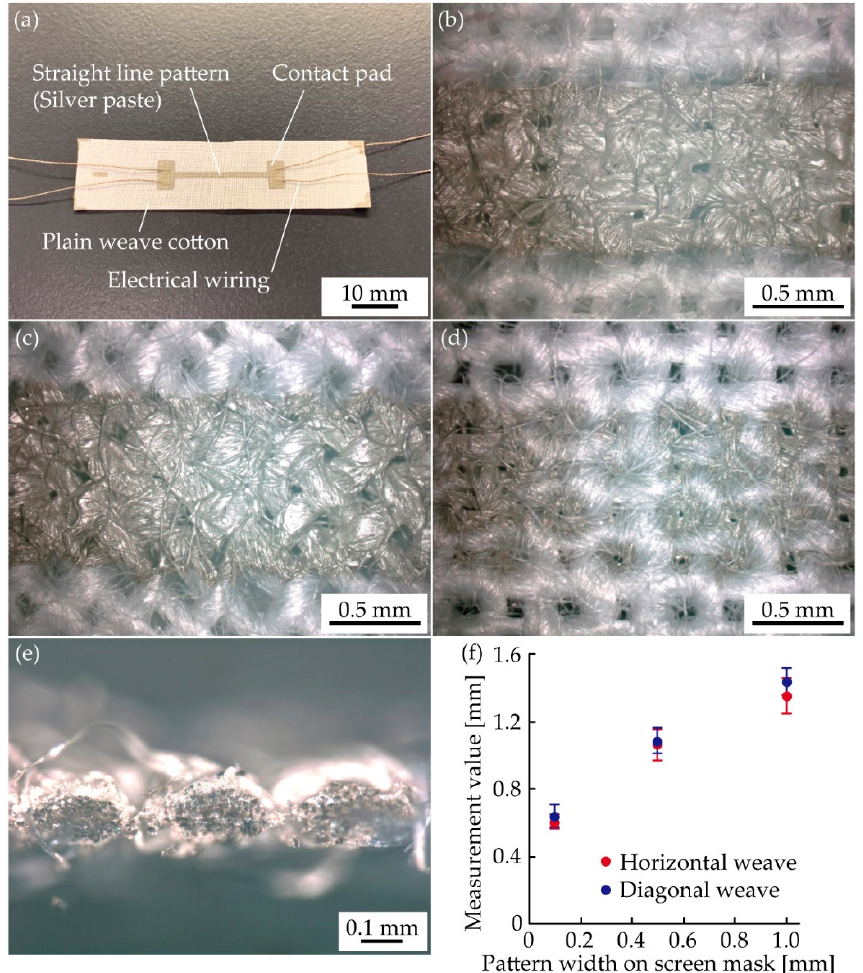
Figure 2. ( a ) Optical image of the prepared sample. Enlarged optical images of a conductive pattern with ( b ) horizontal and ( c ) diagonal weaves. ( d ) Bottom side and ( e ) cross-sectional optical images of a conductive pattern with the horizontal weave. ( f ) Relationship between pattern width on a screen mask and actual measurement value of pattern width.